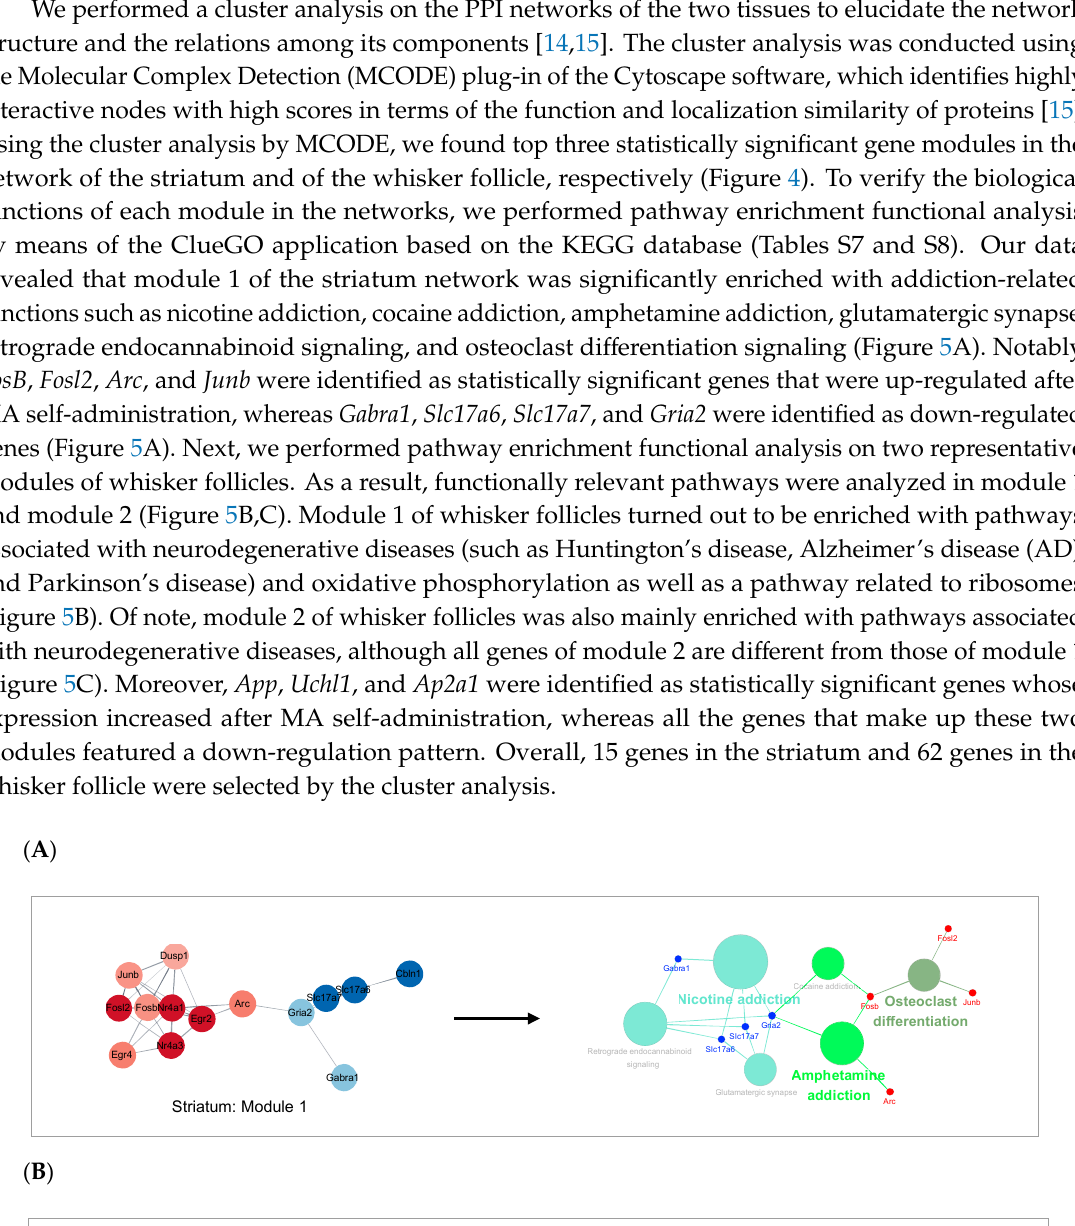
Figure 5. Cluster analysis of DEGs in whisker follicles or in the striatum. ( A – C ) Gene pathway networks that represent significantly enriched KEGG terms and related genes in designated modules. The sub-networks were analyzed and visualized using the ClueGO plug-in in the Cytoscape software. 2.6. Centrality Analysis For the topological analysis of the network, the degrees and betweenness centrality values were calculated with the NetworkAnalyzer tool [15] of the Cytoscape software. To identify hub genes that are important for network cross-talk and biological essentiality [16,17], two topological features, the degree and betweenness centrality, were considered. In each network (the striatum and the whisker